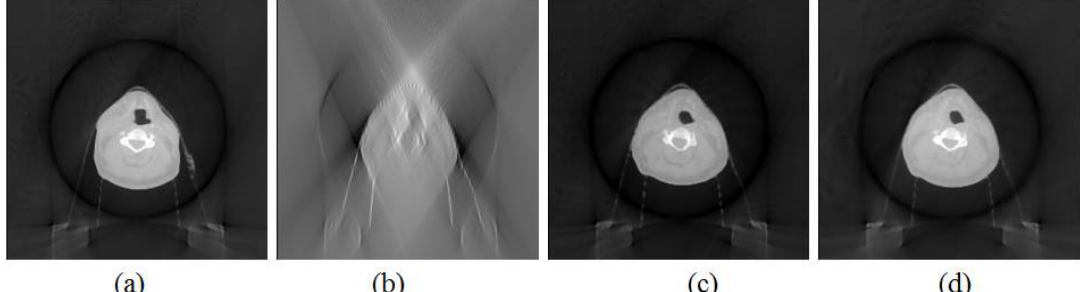
Figure 2. The comparison between images reconstructed with the different reconstruction methods. ( a ) Prior image acquired reconstructed with FDK method using full-angle scan. ( b ) The target image reconstructed with FDK method using limited-angle scan. ( c ) The target image reconstructed with B-spline-based reconstruction method using limited-angle scan. ( d ) The target image reconstructed with FDK method using full-angle scan.